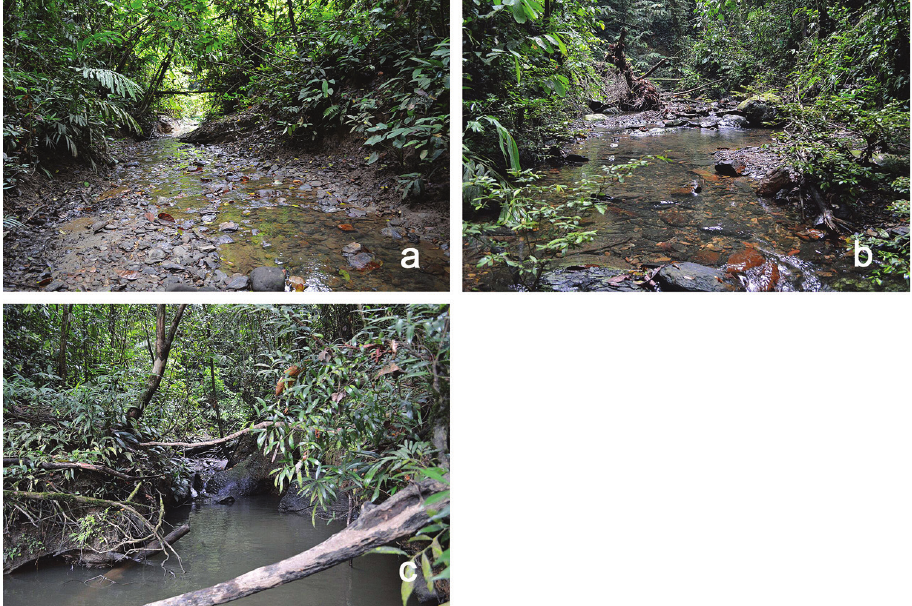
Figure 6. General aspects of Indocloeon larval habitats: a, b I. spathasetis sp. n., tributaries upstream c I. spathase- tis sp. n., tributary confluence with main river. Photographs by Kate Baker (King’s College